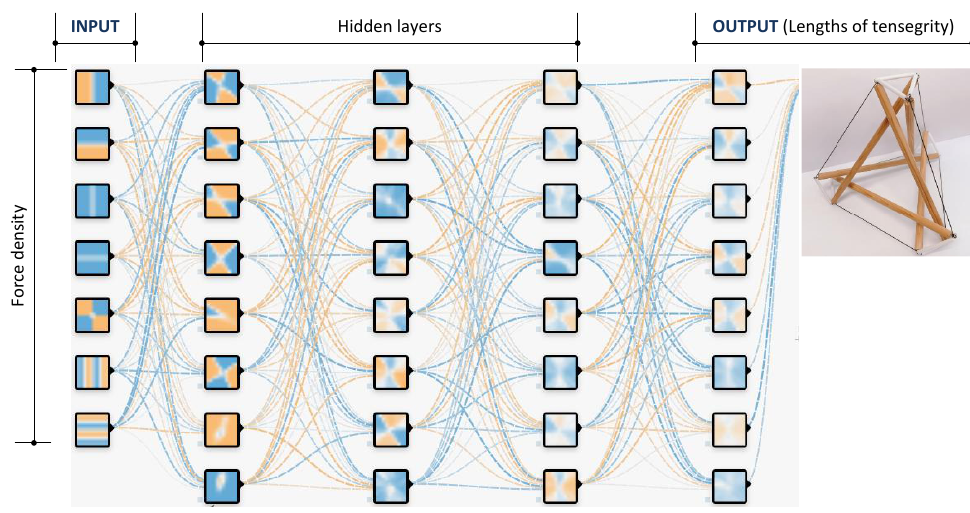
Figure 5. The DNN models with input and output layers denoted for the force densities and lengths of the elements,